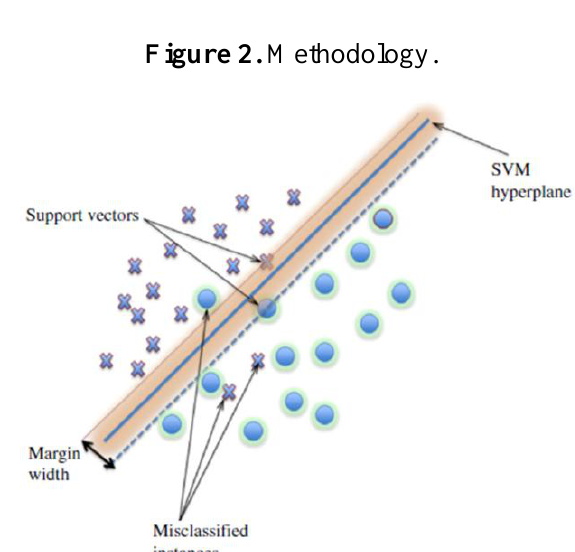
Figure 2. Methodology.